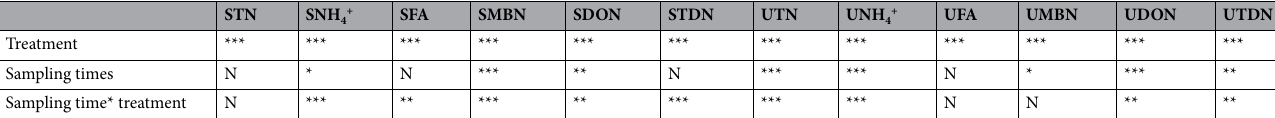
Table 4. Interactive function between treatments and sampling times on nitrogen derived from soil and urea in different nitrogen pools based on the two-way ANOVA analysis. STN: Soil total nitrogen; SNH 4 + : Soil ammonia nitrogen; SFA: Soil fixed ammonia; SMBN: Soil microbial biomass nitrogen; SDON: Soil dissolved organic nitrogen; STDN: Soil total dissolvable nitrogen; UTN: Urea-derived total nitrogen; UNH 4 + : Urea- derived ammonia nitrogen; UFA: Urea-derived fixed ammonia; UMBN: Urea-derived microbial biomass nitrogen; UDON: Urea-derived dissolved organic nitrogen; UTDN: Urea-derived total dissolvable